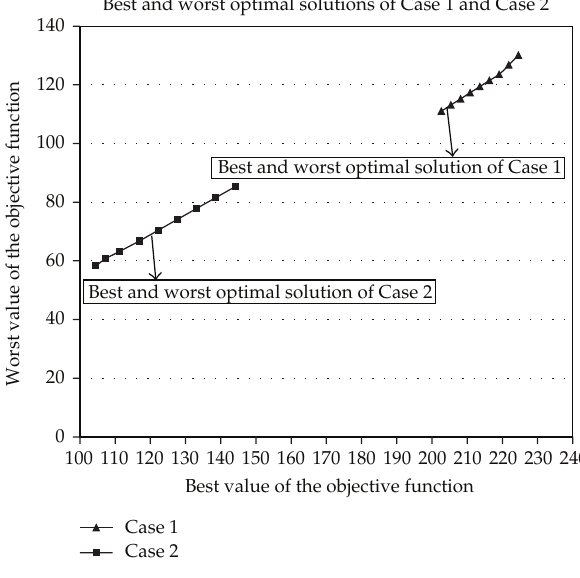
Figure 2: Optimal solutions of Cases 1 and